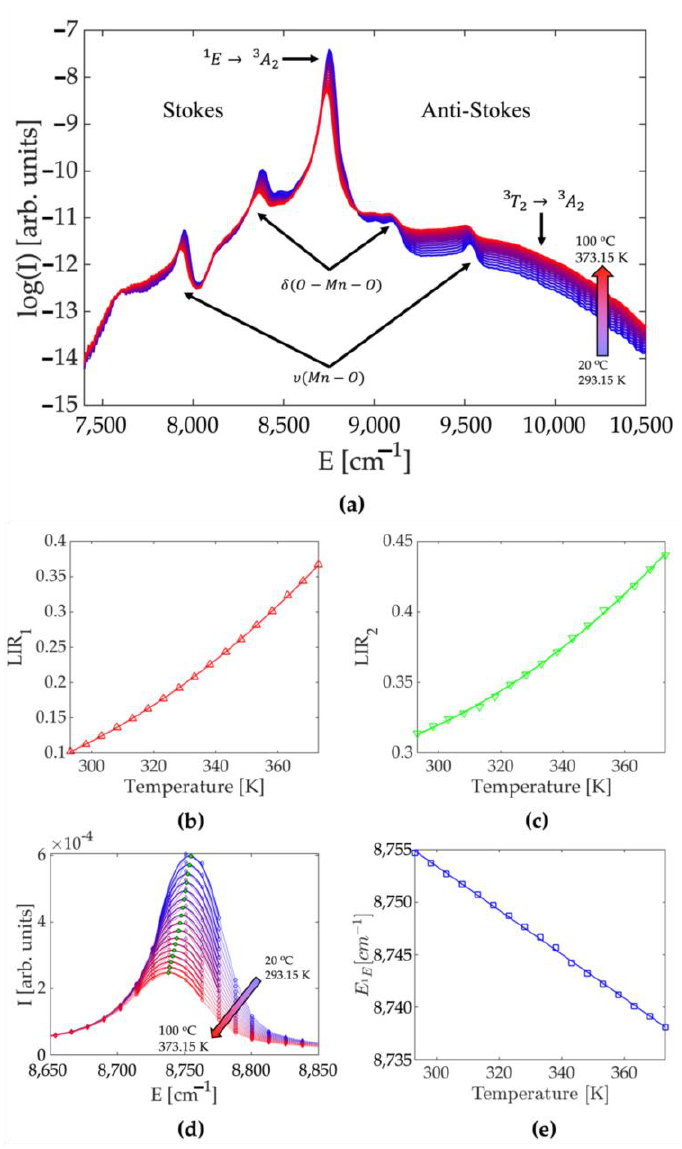
Figure 1. ( a ) Photoluminescence emission spectra of Ca 6 BaP 4 O 17 :Mn 5+ phosphor measured at different temperatures (excitation at 635 nm); ( b ) temperature dependence of the luminescence intensity ratio of 1 E and 3 T 2 emissions ( LIR 1 ; experimental data are represented with symbols; fit to Equation (2) is given by full line); ( c ) temperature dependence of the luminescence intensity ratio of Stokes and anti-Stokes sidebands ( LIR 2 ; experimental data are represented with symbols; fit to Equation (3) is given by full line); ( d ) the redshift of the 1 E emission band upon temperature increase; (e) 1 E emission band maximum variation with temperature ( E 1E ; experimental data are represented with symbols; fit to Equation (4) is given by full line).